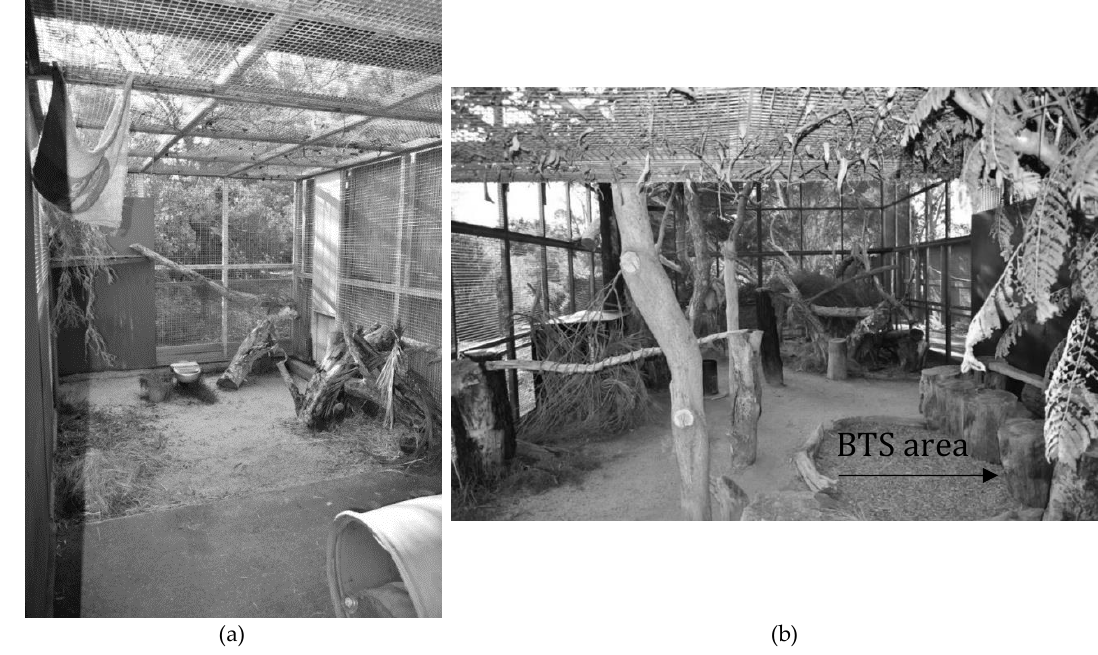
Figure 1. ( a ) Serval pen. The cats could move between the three adjacent pens via hatches that could be closed from the outside by the keeper when necessary. Pens were identical in size and had similar environmental features to the pen shown in the picture. ( b ) Serval yard with a designated area for behind-the-scenes (BTS) encounters on the right.